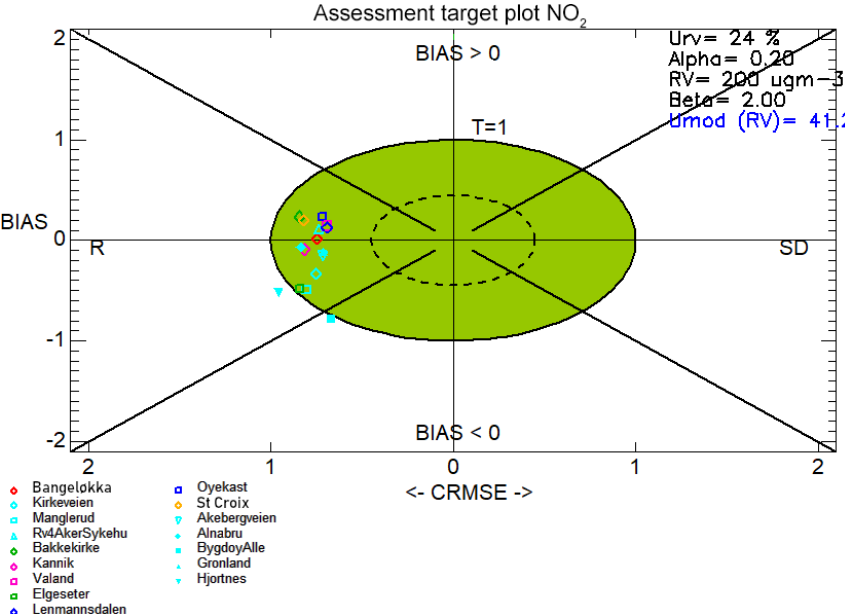
Figure 12. Target plots created using the winter-only (December, January, and February) hourly time series of NO 2 concentrations for all 16 in situ stations used for the model evaluation across all six domains. The symbols are colour-coded according to each model domain: Drammen is red, Oslo is cyan, Trondheim is green, Stavanger is pink, Grenland is dark blue, and Nedre Glomma is orange.